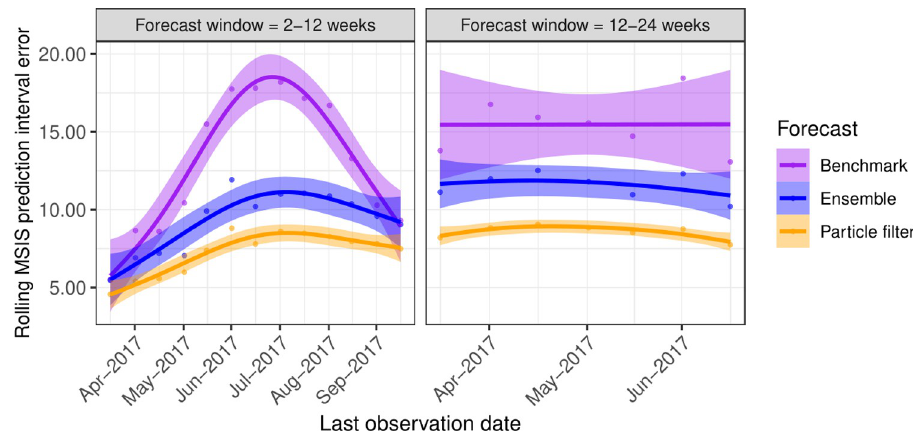
Fig 6. Rolling prediction interval errors for the ETS benchmark, re-trained ensemble and particle filtered ensemble. The benchmark (purple shading) and re-trained ensemble models (blue shading) were iteratively trained on the full dataset as observations became available to simulate a scenario in which models are continually re-calibrated to incoming data. The particle filter (orange shading) involved no retraining for the seasonally adjusted models (ARIMA seasadj and GARCH seasadj ), but instead used iterative assimilation of incoming observations via Sequential Monte Carlo. Lines and shaded areas show trends and 99% confidence intervals estimated using cubic regression